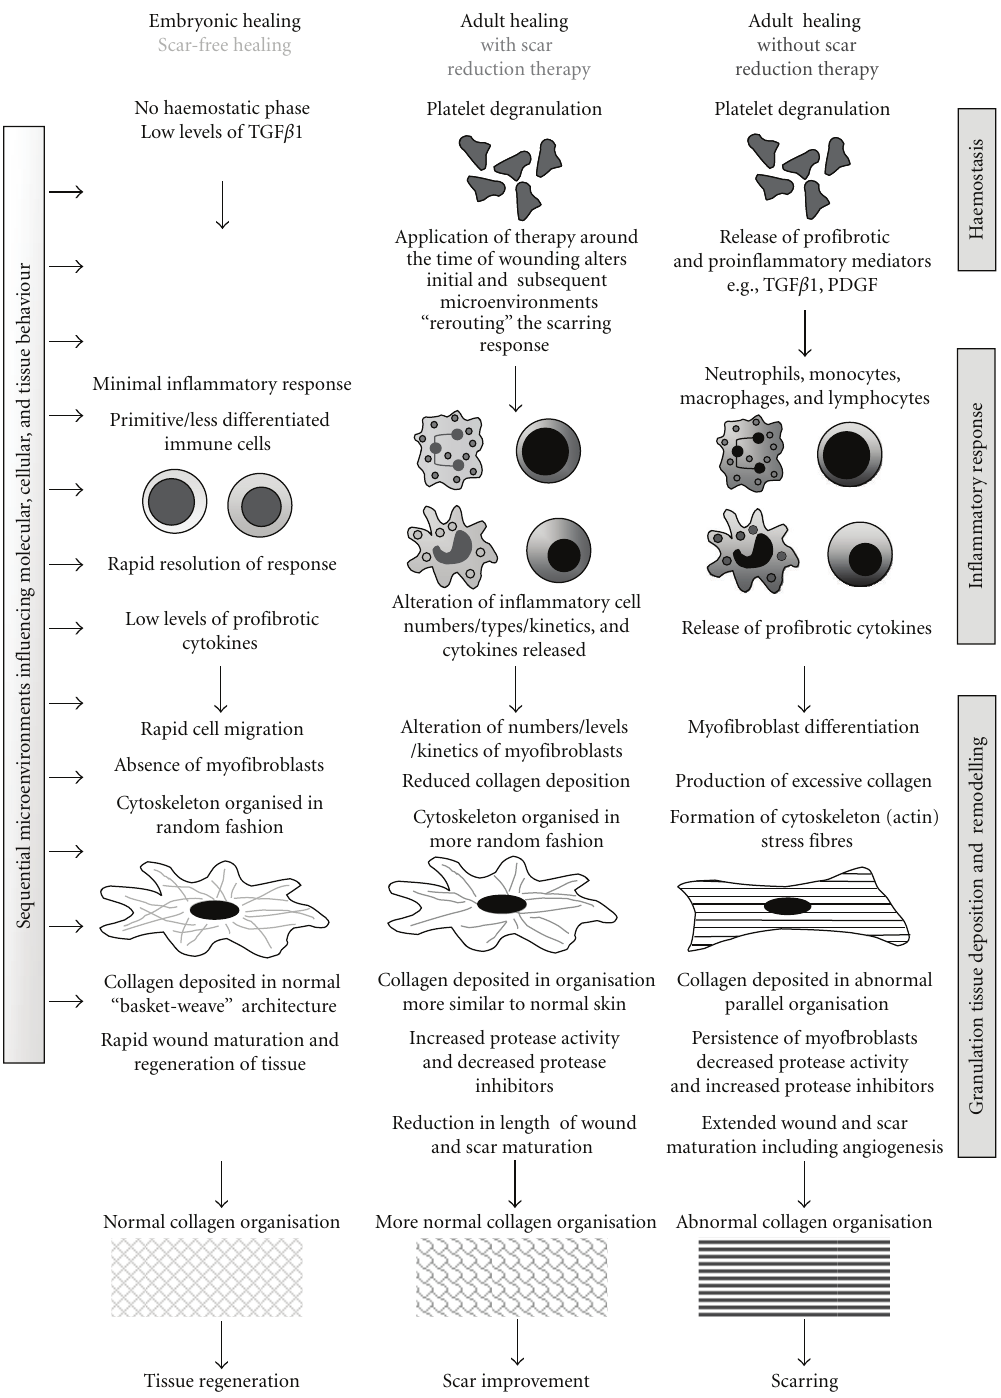
Figure 5: Mechanisms and processes associated with scar-free healing, scar-forming healing and prophylactic scar reduction therapies.